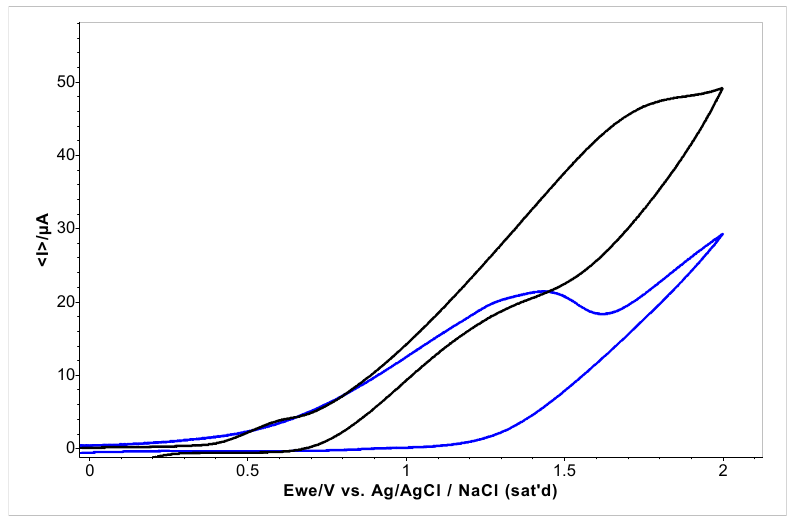
Figure 7. Cyclic voltammograms of A. foeniculum AdB EO (blue) and standard compound eugenol (black), E = ±2 V/Ag/Ag Cl sat , at 100 mVs − 1 .